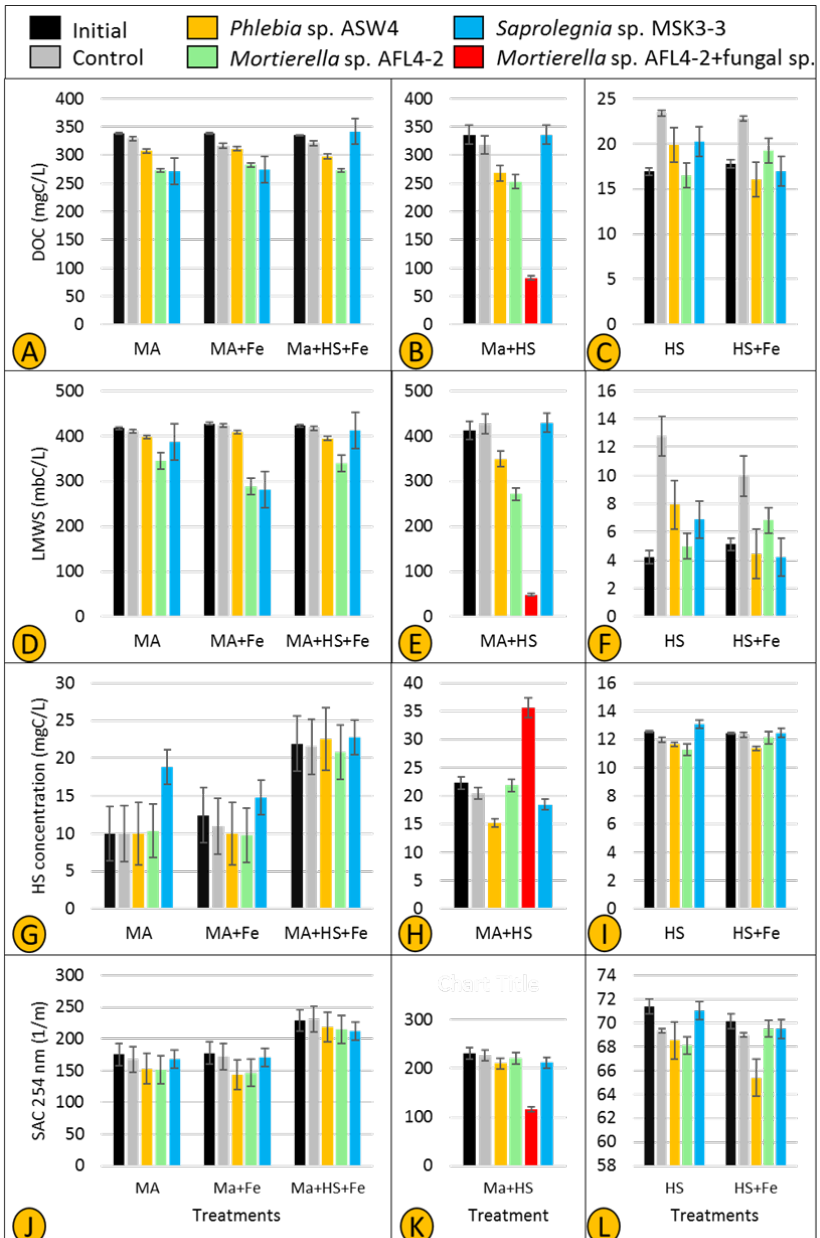
Figure 9. Concentration of dissolved organic carbon (DOC) ( A – C ), low molecule weight substances (LMWS) ( D – F ), and the levels of HS (including building blocks) ( G – I ) and SAC 254 nm ( J – L ) in six treatments (see material and methods section for more detail) inoculated separately by two fungal strains ( Phlebia sp. ASW4 and Mortierella sp. AFL4-2) and one Saprolegniales strain ( Saprolegnia sp. MSK3-3), along with Mortierella sp. AFL4-2 + fungal sp., after 21